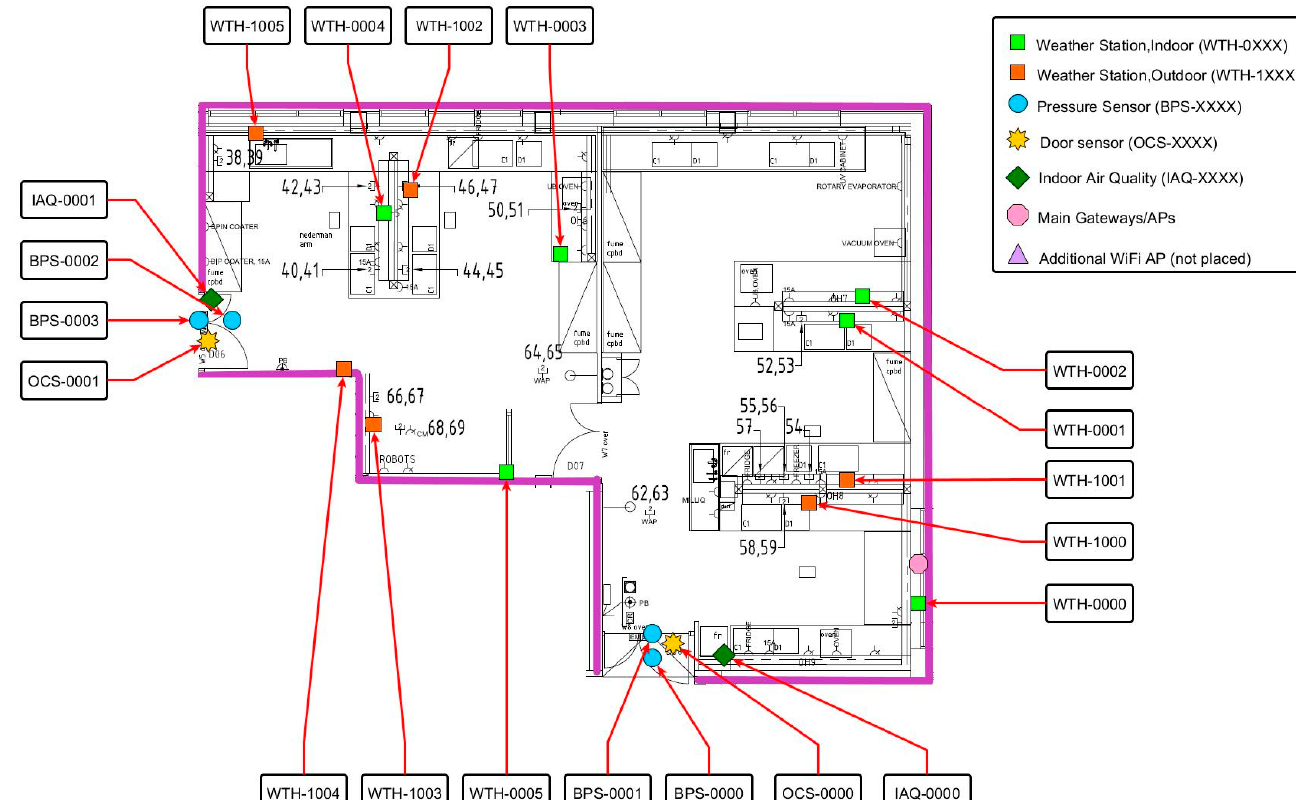
Figure A7. Sensor placement for the university laboratory.